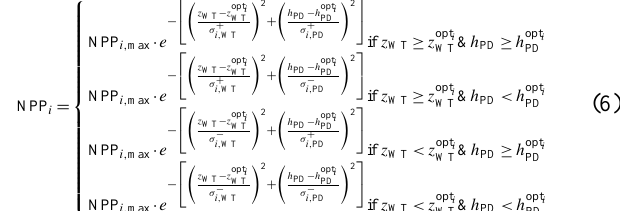
) and peat depth ( h opt ). WT PD and σ + ). Maximum NPP (NPP max ) compares each i, WT i, PD